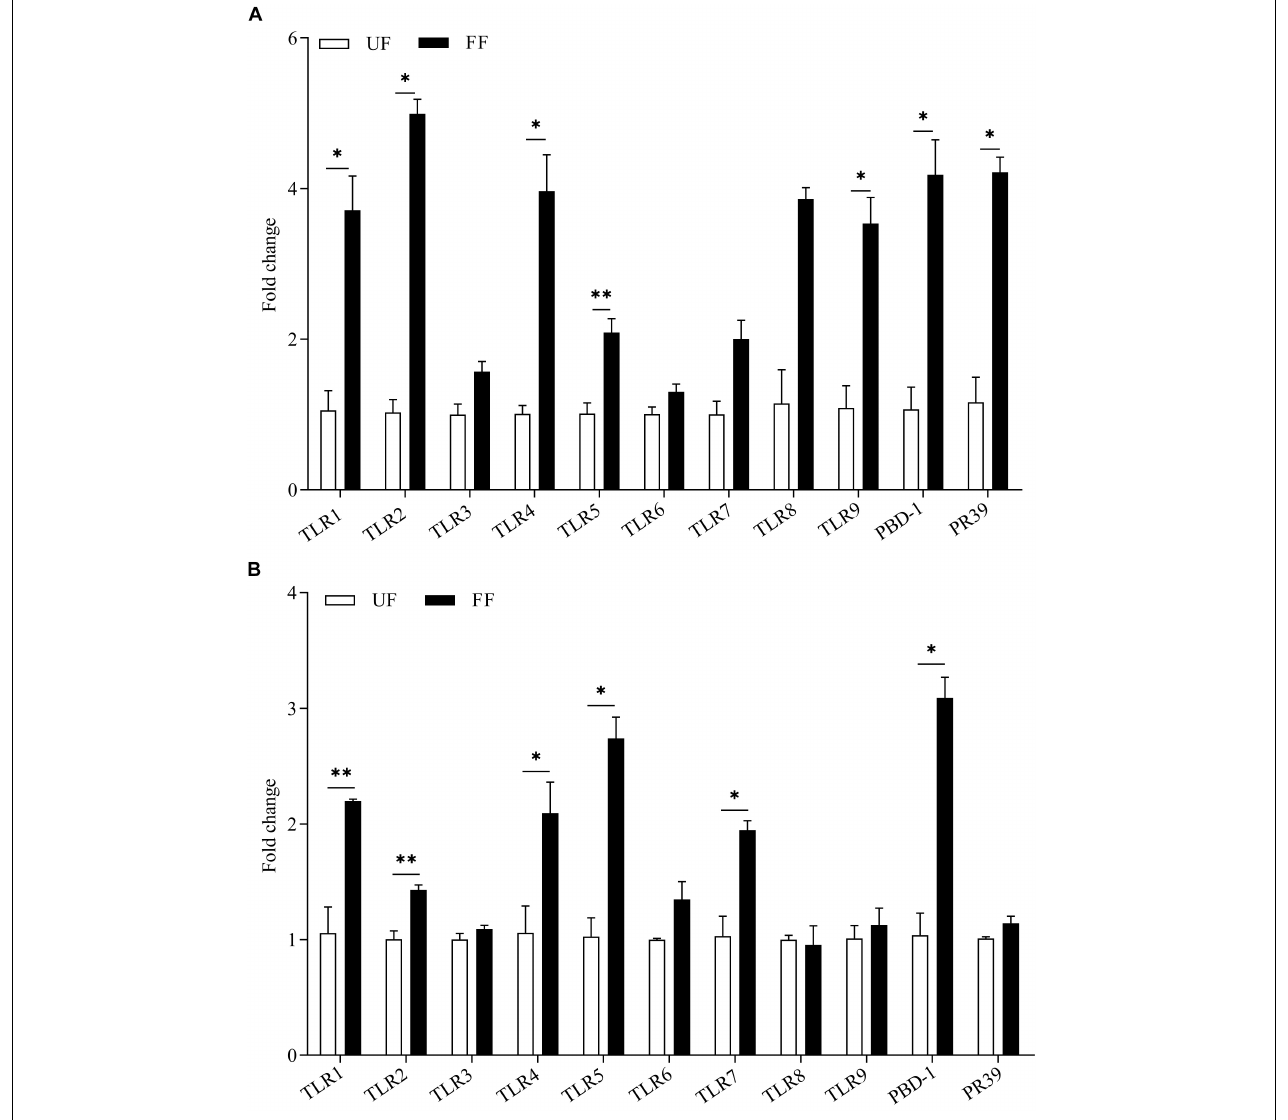
FIGURE 2 | Expression levels of TLR genes and antimicrobial peptides in the duodenum (A) and colon (B) . The UF group was designed as one-fold change. UF, pigs fed with unfermented corn-soybean meal; FF, pigs fed with fermented corn-soybean meal. Data are presented as the mean ± SEM ( n = 6). ∗ P < 0.05 and ∗∗ P <